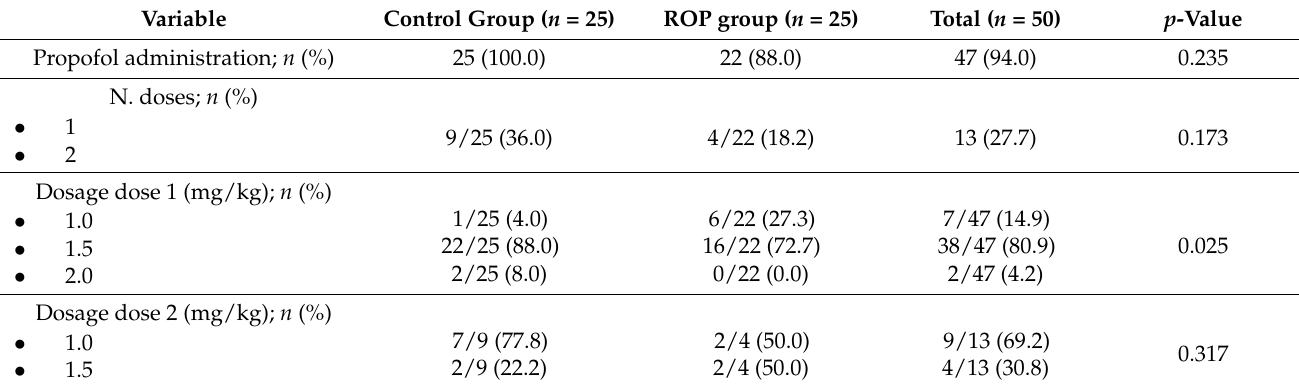
Table 1. Group-wise management of the sample with propofol (treatment vs.